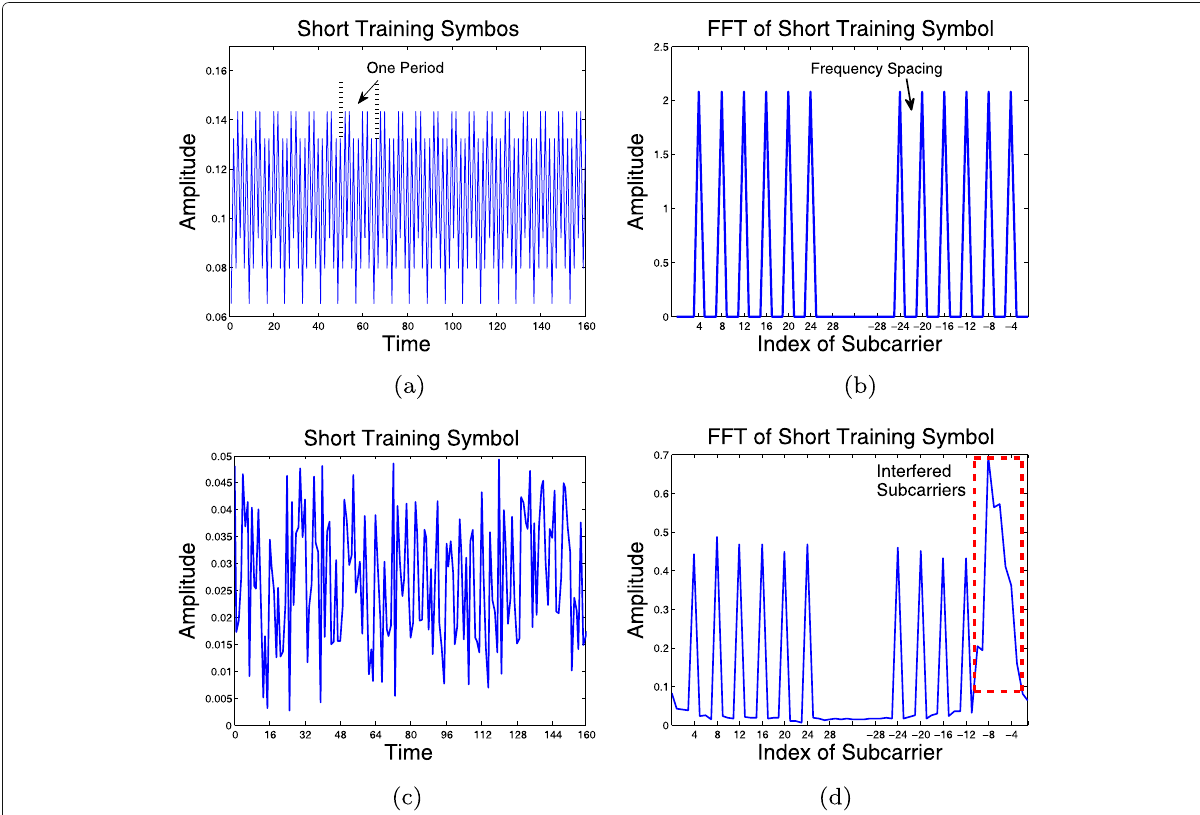
Fig. 4 Periodicity of STS is destroyed by the interference. a Clean STS sequence. b FFT of clean STS. c Interfered STS sequence. d FFT of interfered